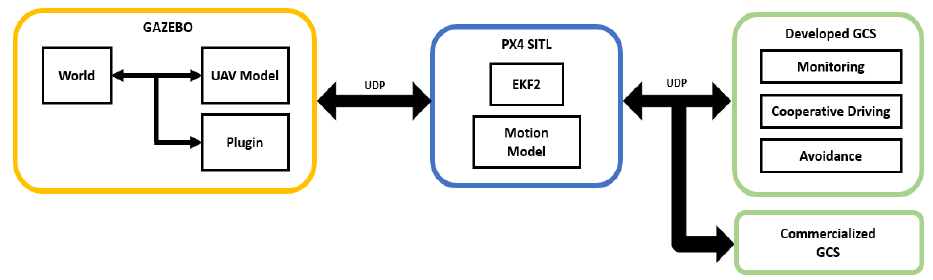
Figure 9. Configuration of the virtual simulation